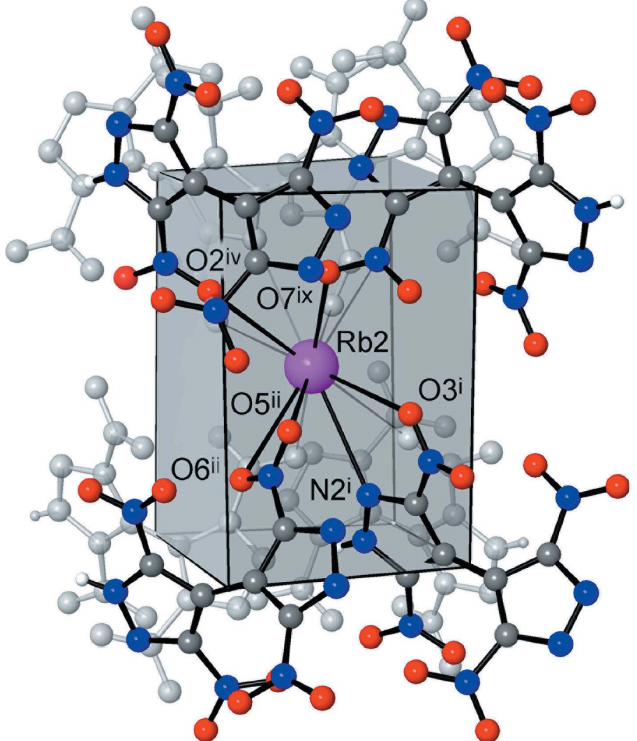
Figure 3 The Rb2 ion resides inside a supramolecular prism (represented here as a gray box) adopted by eight anions, which complete the coordination environment. The vertices of the prism are built through the mid-points of the central C—C bonds of the molecules. The environments of Rb1 and the respective Cs ions in the structure of ( 2 ) are similar. [Symmetry codes: (i) x , y + 1, z ; (ii) (cid:3) x + 1 , y + 1 , (cid:3) z + 1 ; (iv) x (cid:3) 1 , y + 1 , z ; (ix) (cid:3) x , (cid:3) y + 1, 2 2 2 2 2 (cid:3) z .]